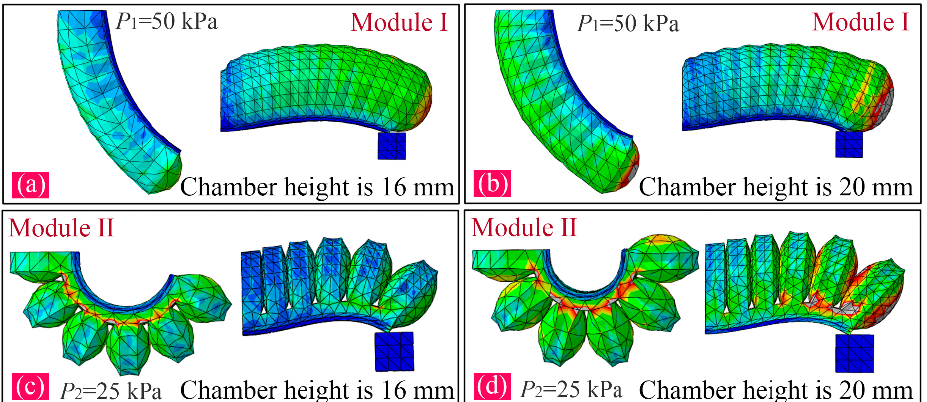
Figure 5. Simulation results when the chamber height adopts different values: ( a ) bending and tip force of module I at a chamber height of 16 mm, ( b ) bending and tip force of module I at a chamber height of 20 mm, ( c ) bending and tip force of module II at a chamber height of 16 mm, and ( d ) bending and tip force of module II at a chamber height of 20 mm.